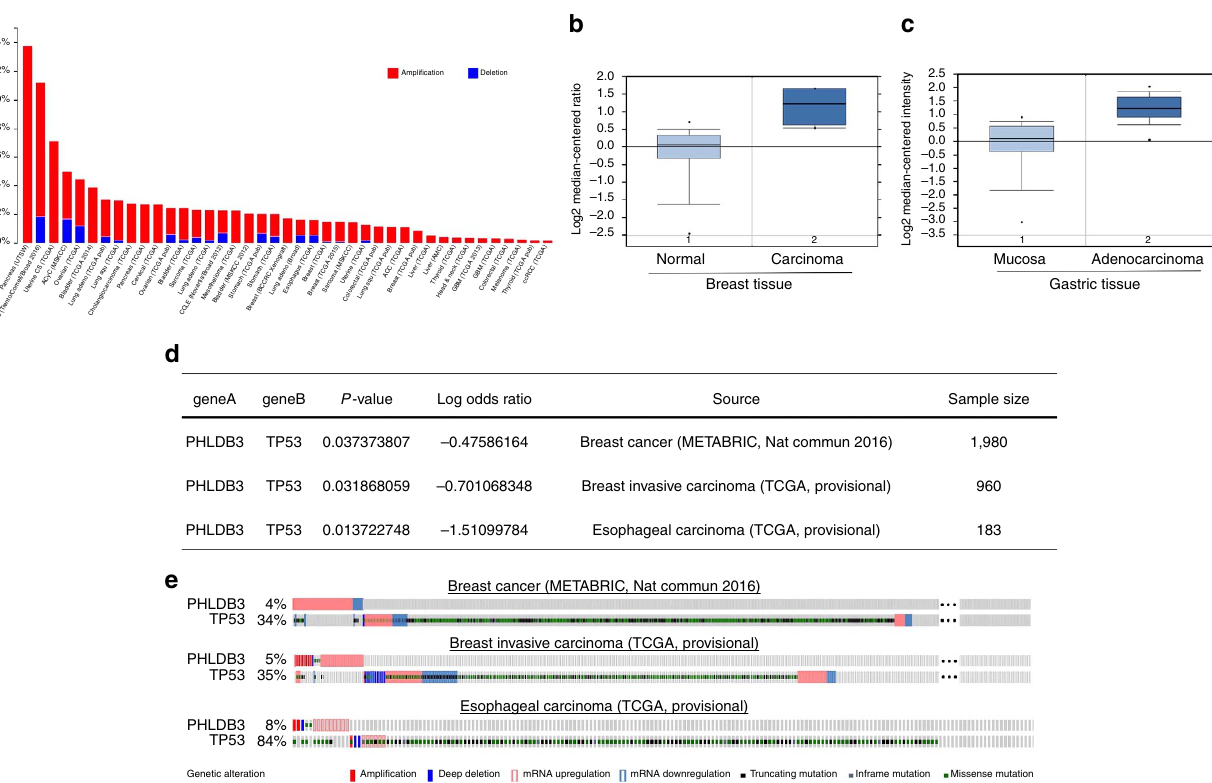
Figure 3 | High expression of PHLDB3 is found in multiple cancers and mutually exclusive to TP53 mutations in some cancers. ( a ) TCGA database was searched, and the data were modified from the cBioPortal for Cancer Genomics (http://www.cbioportal.org/). ( b , c ) The expression profile of PHLDB3 in cancers and normal tissues was searched in Oncomine Gene Browser (http://www.oncomine.org/). The results in TCGA Breast Dataset ( b ) and DErrico Gastric Dataset ( c ) are shown. ( d ) Analysis of mutual exclusivity was retrieved from cBioPortal and gene alteration status of PHLDB3 and TP53 of individual sample is depicted in e